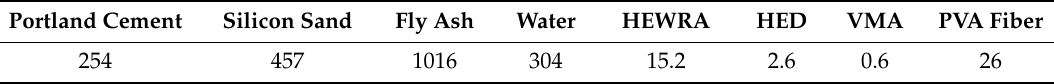
Table 6. Mixture proportions of the material (kg / m 3